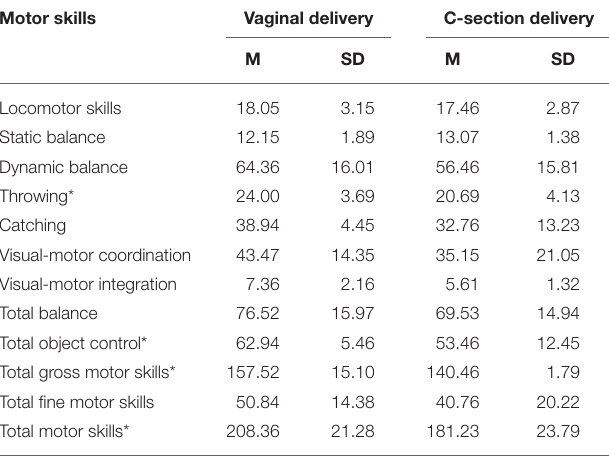
TABLE 3 | Means (M) and Standard Deviations (SD) of motor skills scores according to feeding type during the first 4 months of life. Motor skills